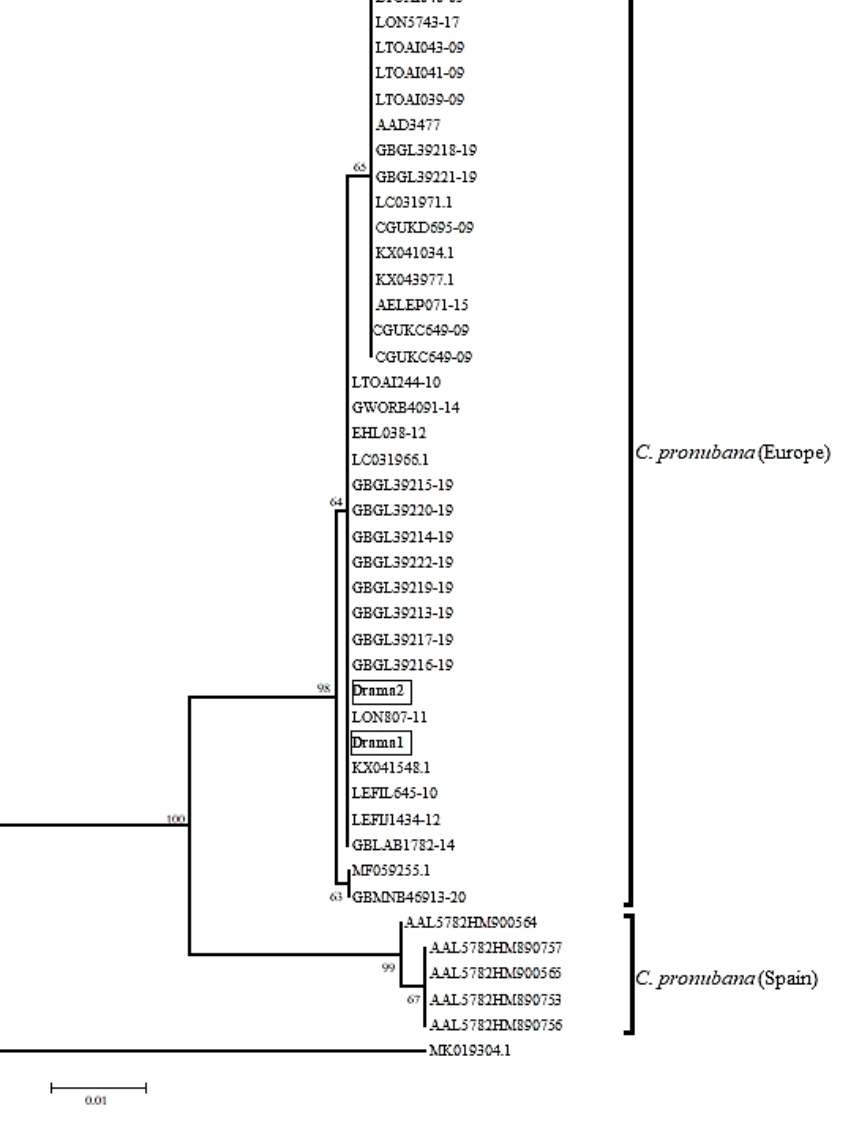
Figure 2. Rooted NJ phylogenetic tree (500 bootstrap replicates / K-2P) that contains the two C. pronubana sequences from Greece (Drama 1 and 2) and all the available C. pronubana sequences in NCBI and BOLD databases. Scale-bar stands for 0.01 K-2P distance.